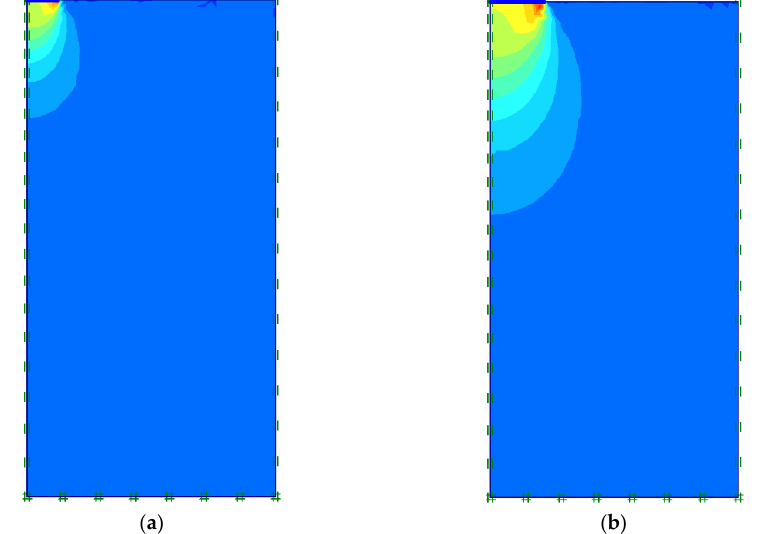
Figure 16. Vertical stress distribution with HS model: ( a ) 85 mm; ( b ) 150 mm.